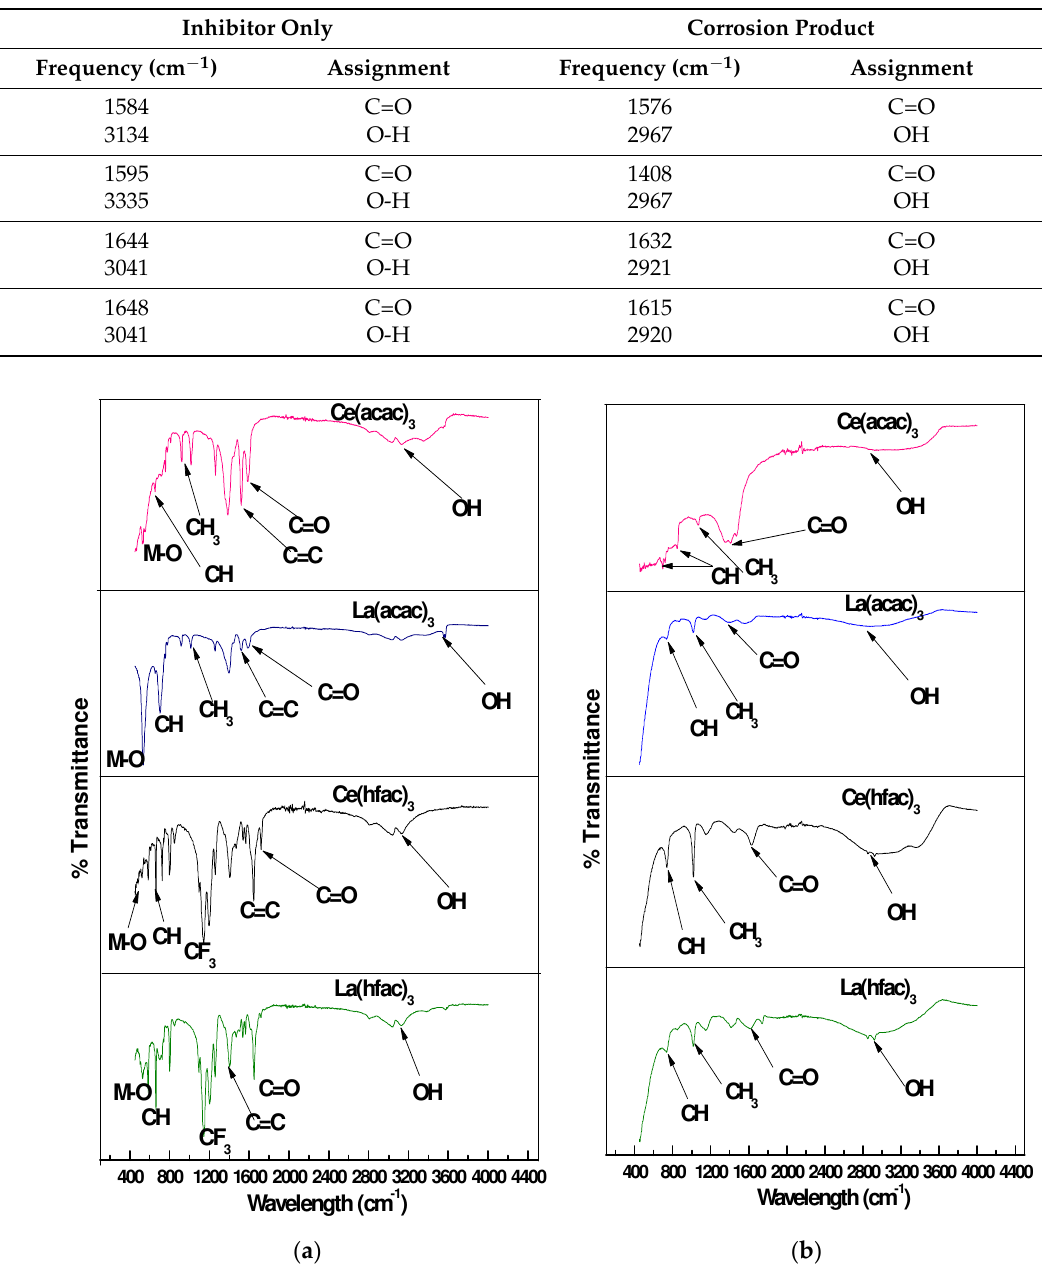
Figure 12. IR spectra of REE( β -diketone) 3 inhibitors and the corrosion products formed on mild steel and 304 stainless steel: ( a ) REE β-diketone inhibitor; ( b ) steel REE β-diketone inhibitor film. Table 5. IR frequency bands of inhibitors and the corrosion products formed on mild steel and 304 stainless steel.